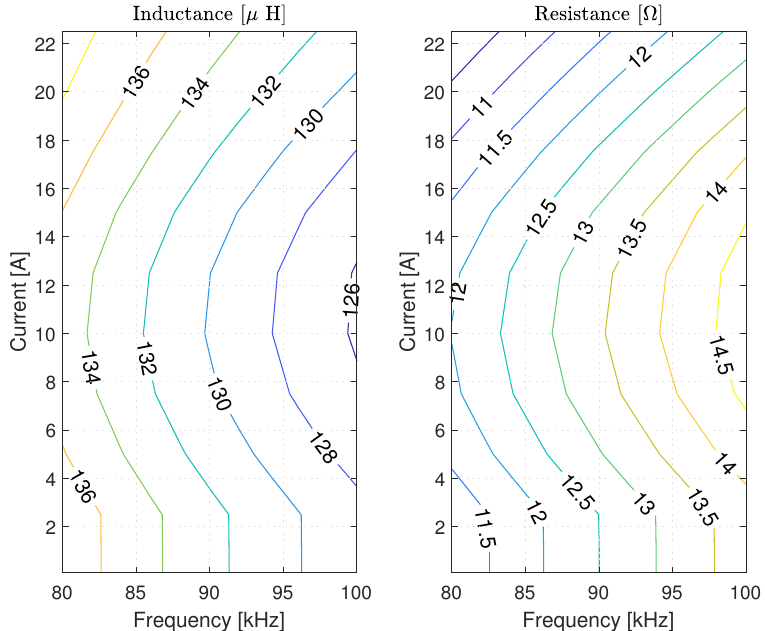
Figure 5. Maps or equivalent resistance and inductance for the load considered in Figure 1 in frequency–current interval of (80–100 kHz × 0.1–22.5 A) at room temperature. The data are sampled for each 2 kHz and 2.5 A, generating a 11 × 11 map. The optimal working point in the described range is found at (10 A, 100 kHz). The sweep parameter simulation was ran on a 16Gb-RAM calculator @3.4 GHz. The average analysis calculation time for each couple of parameters is 15 min.